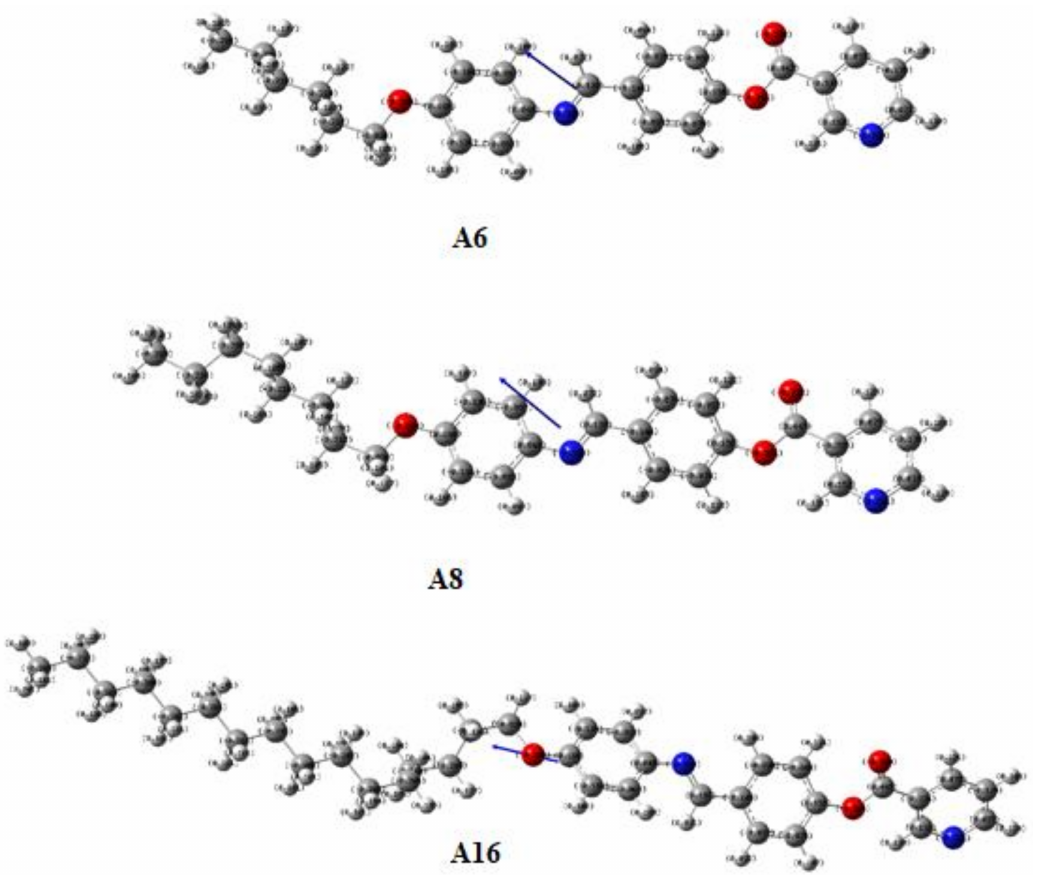
Figure 4. Atomic charges and dipole moment vector for the optimized structure of present series An , calculated at B3LYP/6-311g(d,p)